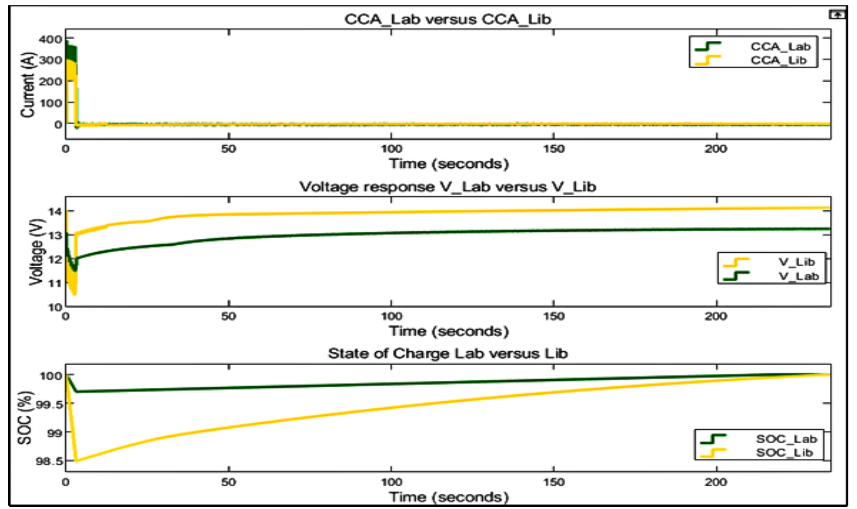
Figure 20. The CCC, SoC and voltage response of HESS during charging mode for case three (a).